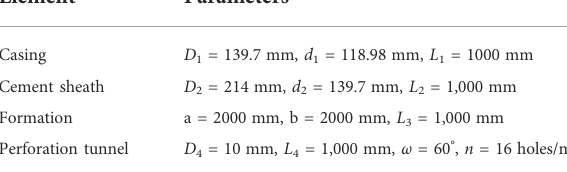
TABLE 1 Model geometric parameters. Element Parameters